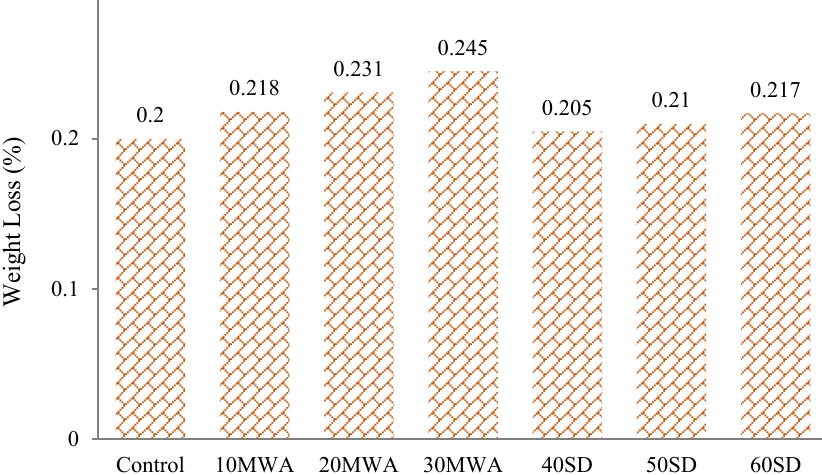
Figure 6. Weight loss of specimen after exposure to acid attack .